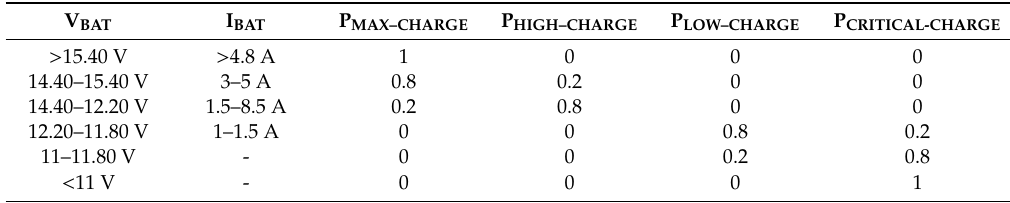
Table 5. Probabilities and possible states for charge level.